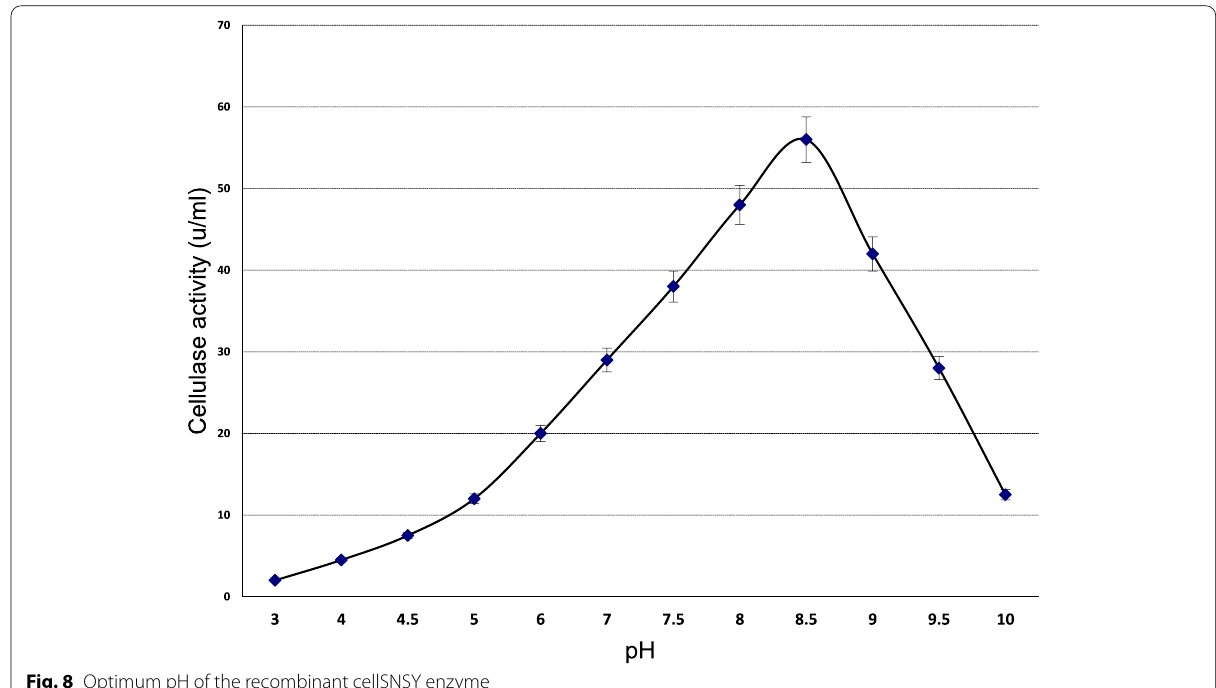
Fig. 8 Optimum pH of the recombinant cellSNSY enzyme